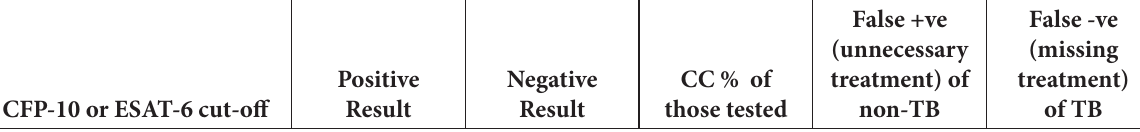
CFP-10 or ESAT-6